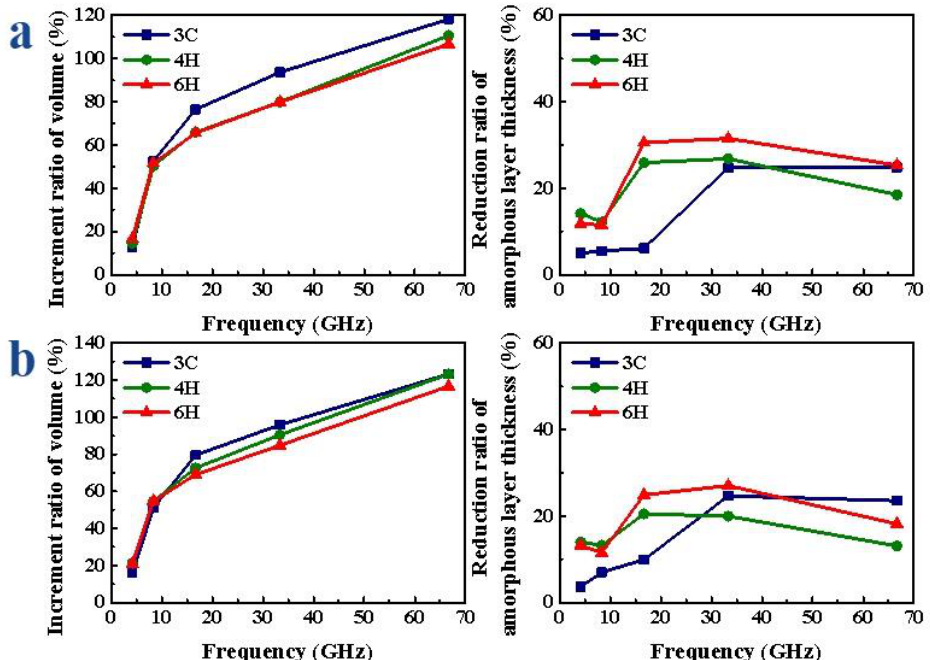
Figure 9. Amorphous atoms’ volume increment and amorphous atoms’ layer thickness reduction ratio of SiC polytypes with different frequencies: ( a ) Si-face and ( b ) C-face of SiC. After applying vibration, the volume of the amorphous layer significantly increased